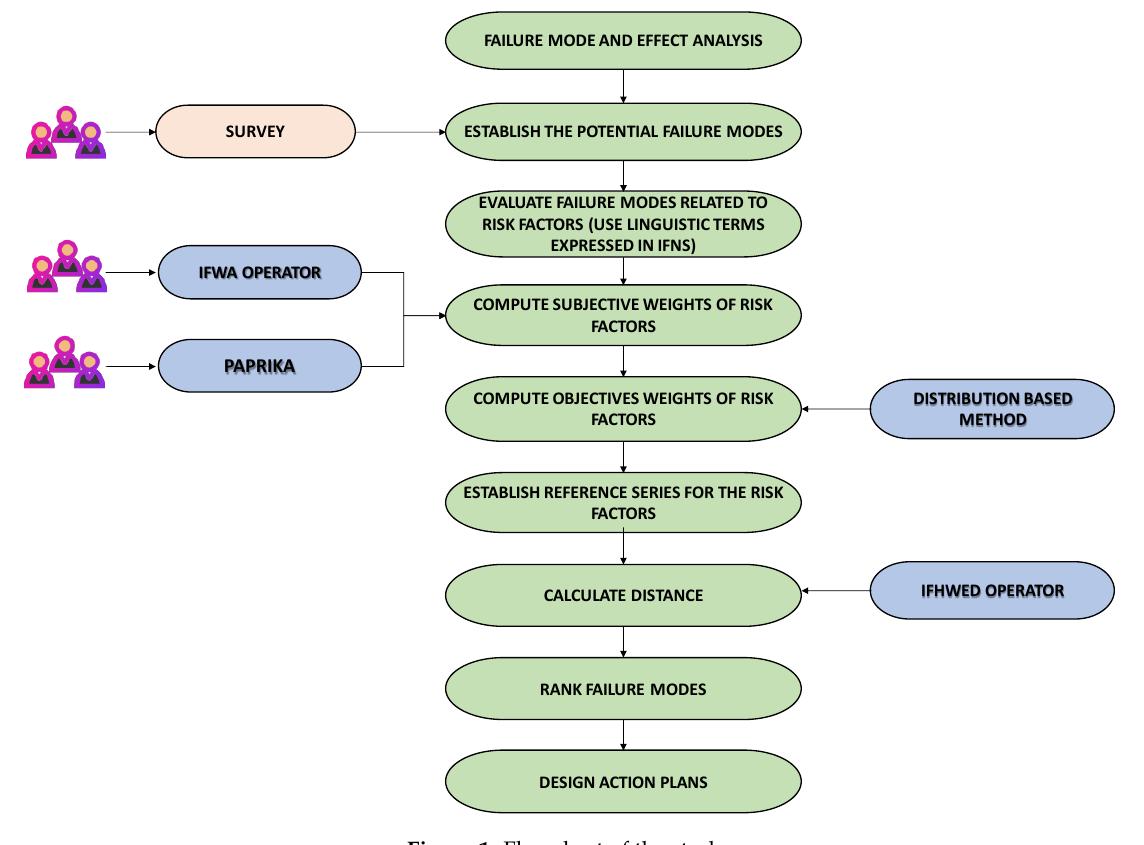
Table 5. Nuclear Medicine Department segregation failure